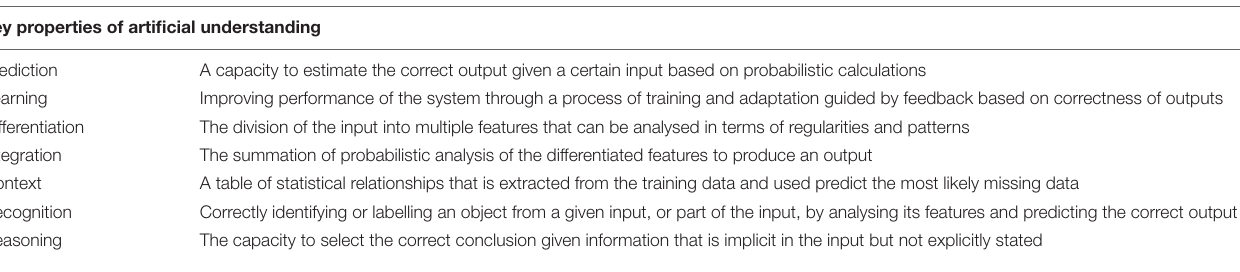
TABLE 3 | Summary of the key properties of artificial understanding based on the cases of natural language processing and image